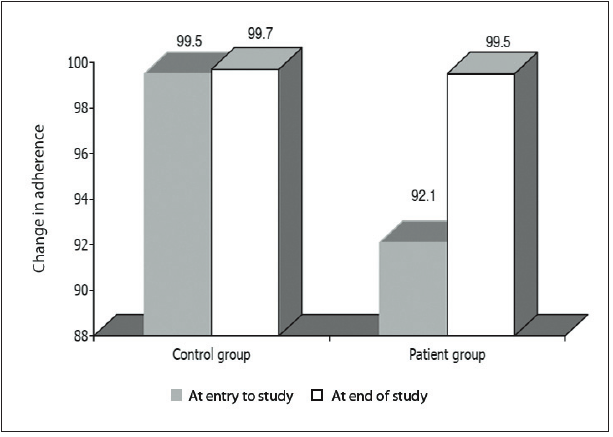
Fig. 1. Changes in ART adherence in the control and patient